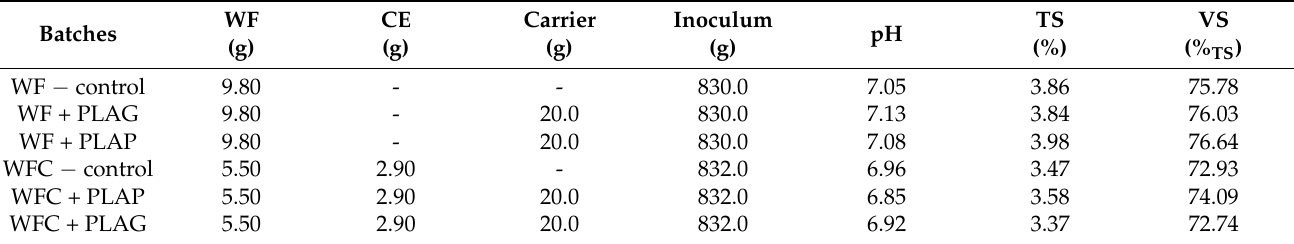
Table 2. Composition and selected properties of the substrate/inoculum